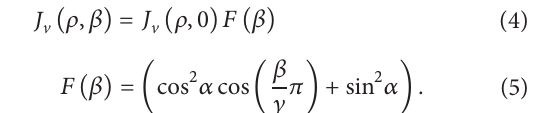
small ( 𝜃 = 8 ∘ < 𝛼 ). The range of horizontal axis indicates the distance between a point on 𝐿1 󸀠 and the top of the